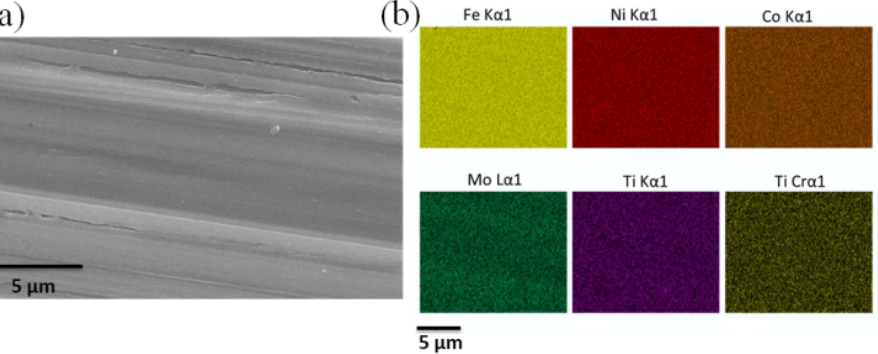
Figure 2. ( a ) Scanning electron microscope (SEM) micrograph of the grade 300 maraging steel sur- face after treatment and ( b ) energy-dispersive X-ray spectroscopy (EDS) elements map of the main constituents.